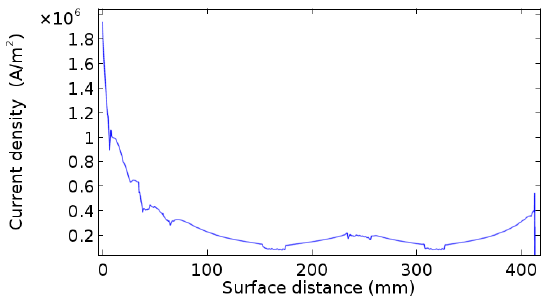
Figure 12. Current density along No.1 insulator under contaminated and wet condition.